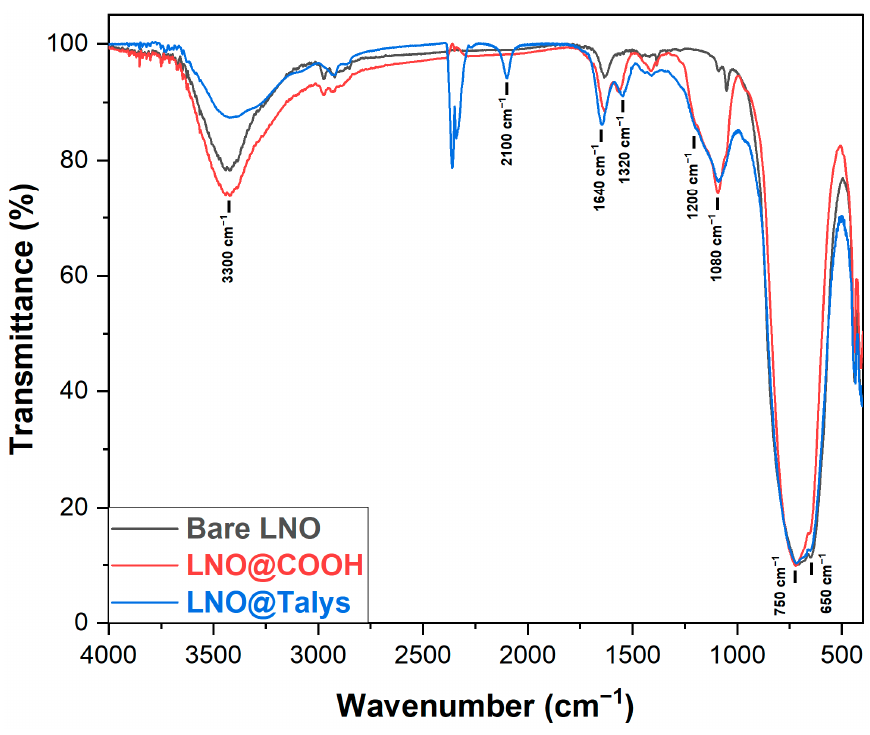
Figure 4. FTIR spectra of bare LNO NPs (black), LNO@COOH NPs (red), and LNO@Talys NPs (blue), normalized with respect to the Nb signal.